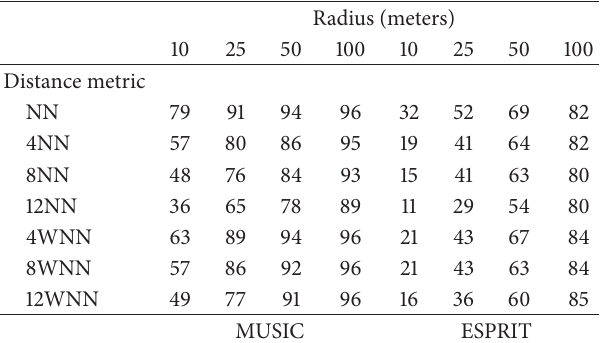
Table 3: Number of “hits” within given radius to actual location for each distance metric out of 100 trials. SNR = 0 dB; number of antennas = 8; oversampling factor = 2; distance-threshold = 0.2, Scenario A.